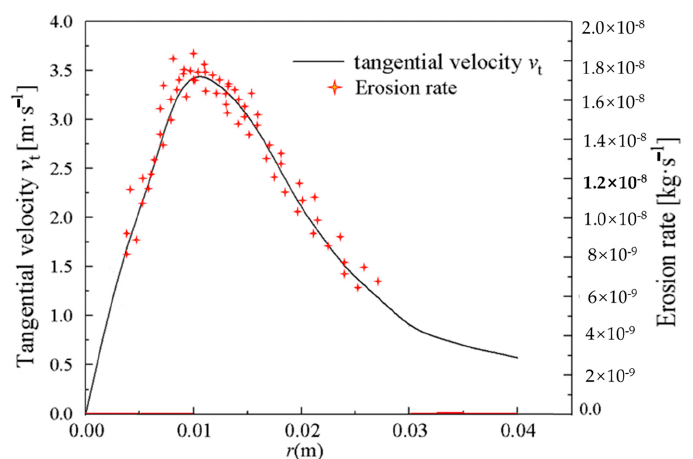
Figure 15. Tangential velocity and erosion rate change with vortex core radius.